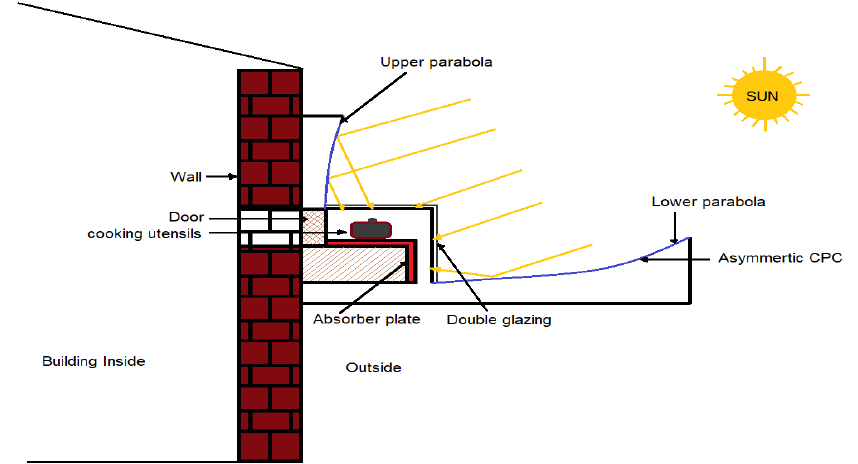
Figure 2. Building integrated solar cooker. Reprinted/adapted with permission from (2013) Harmim et al. [39]. Harmim et al.